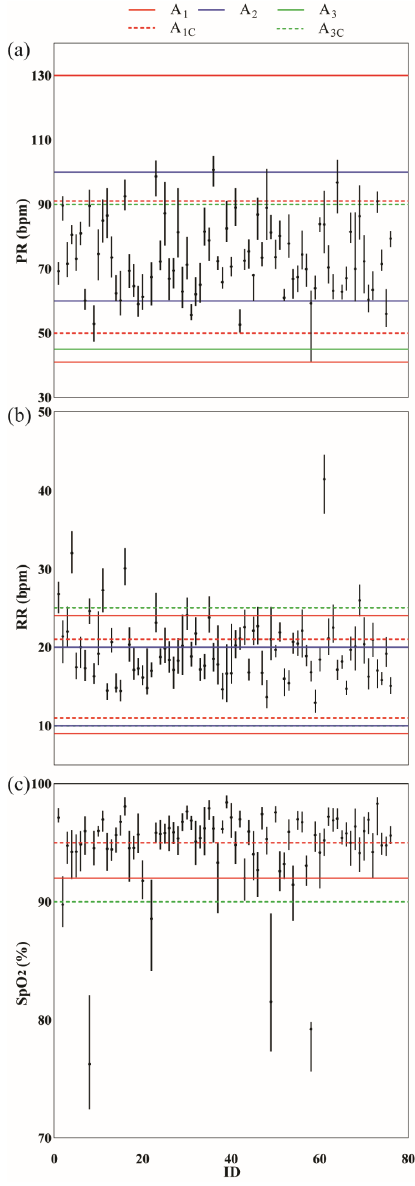
Figure 2. Median (IQR) vital signs for each patient in the healthcare at home dataset ( VS SD ). ( a ) Pulse rate (PR); ( b ) Respiratory rate (RR); ( c ) Oxygen saturation (SpO 2 ). The horizontal lines indicate the threshold values set for each alarm ruleset. Solid horizontal lines are thresholds used in single vital sign rules: A 1 (purple), A 2 (cyan), A 3 (magenta). Dashed horizontal lines are thresholds used in combination rules: A 1C (cyan), A 3C